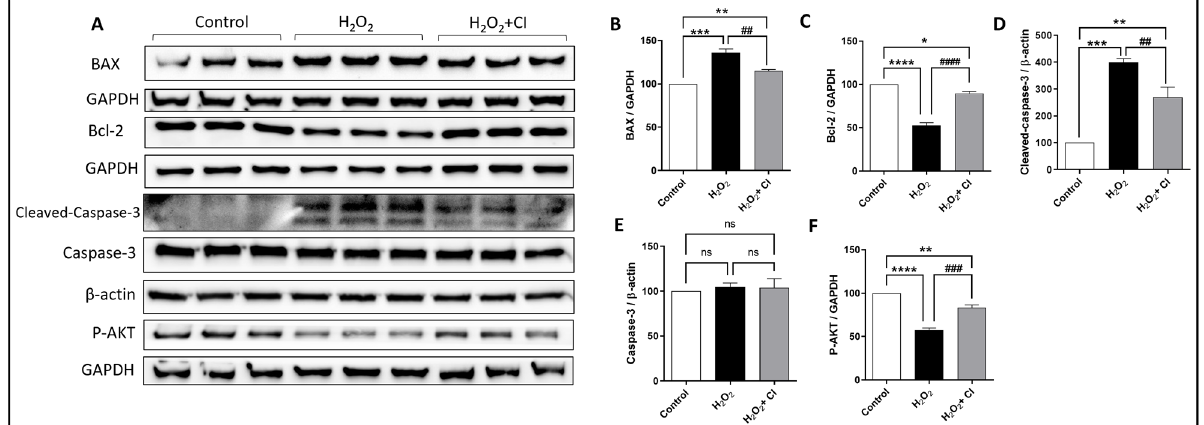
Figure 5. The effect of CI on BAX, Bcl-2, Caspases, and p-Akt expression in H 2 O 2 -stimulated SH-SY5Y cells. SH-SY5Y cells were treated with 200 µ M H 2 O 2 with or without 10 µ M CI for 5 h; then, the cell culture medium was replaced with a fresh one with or without 10 µ M CI for another 24 h. ( A ) WB immunoblots of BAX, Bcl-2, and p-Akt proteins in the Sh-SY5Y cell lysate. ( B , D ) Analysis of WB shows that the expression of BAX and cleaved caspase-3 were significantly upregulated in the H 2 O 2 group compared to the control and were downregulated in the CI-treated group. ( E ) The expression of total caspase-3 showed no significant change in all groups. ( C , F ) Treatment with CI increases both Bcl-2 and p-Akt protein expression significantly compared to the H 2 O 2 -stimulated control. Data are expressed as mean ± SEM of three independent experiments where p < 0.05 was considered significant. * p < 0.05, ** p < 0.01, *** p < 0.001, **** p < 0.0001 relative to control group. ## p < 0.01, ### p < 0.001, #### p < 0.0001 relative to H 2 O 2 group. (See Figure S4 for original Western blot